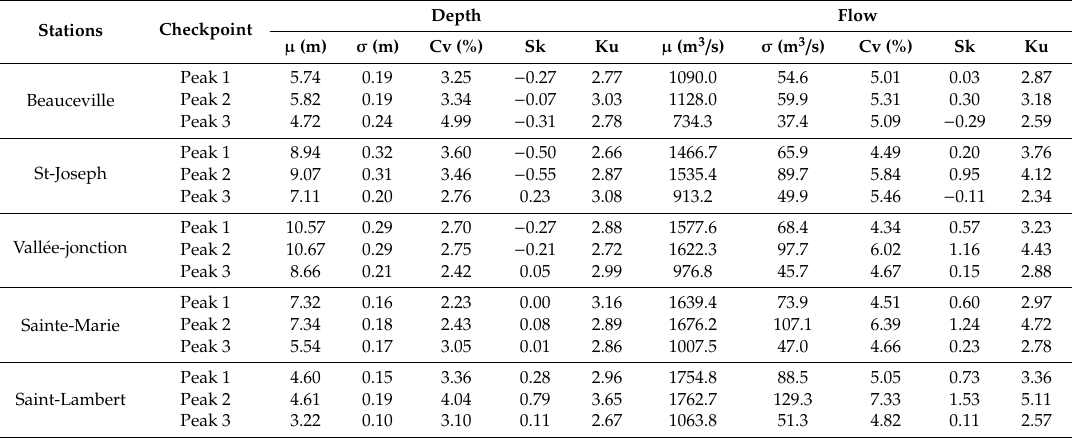
Figure 12. Moving average of the coe ffi cient variation (CV) in % for depth ( D ) and flow ( Q ) at control stations (colored lines) for peak 1, 2, and 3: ( a ) Depth, ( b ) Flow. Table 5. Summary of uncertain water level and flow moments: mean ( µ ), standard deviation ( σ ), coe ffi cient of variation (Cv), skewness (Sk), and kurtosis (Ku) for the considered peak flows and control